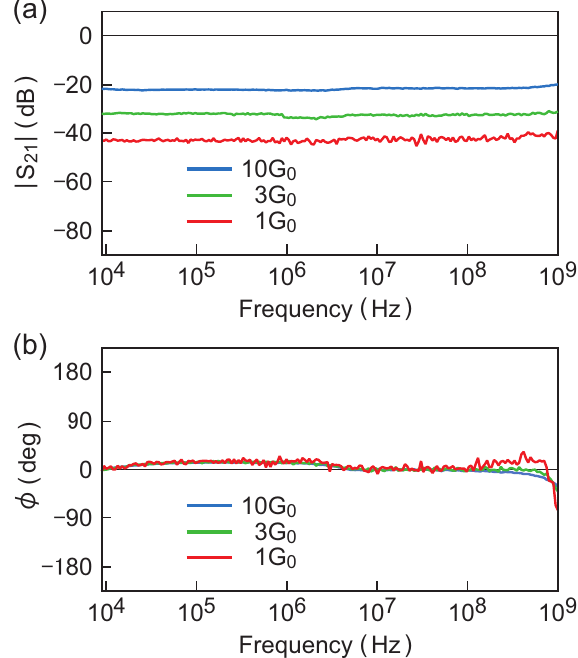
Figure 7. The S 21 parameter measured on the 10 G 0 , 3 G 0 , and 1 G 0 contacts of Au and for frequencies up to 1 GHz. Panels ( a ) and ( b ) show the spectrum of | S 21 | and that of the phase φ , respectively. Note that φ ∼ 0 over the entire frequency range while | S 21 | = ( constant ) with a constant that varies in proportion to the contact conductance. Reprinted from [60] with the permission of AIP